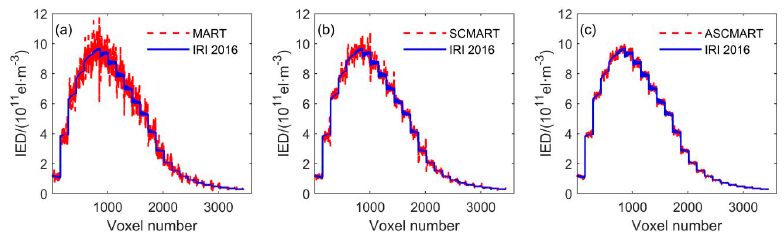
Figure 3. Comparison between the simulated ionospheric electron density distribution of the IRI 2016 model and the tomographic results of the three algorithms. ( a ) MART ( b ) SCMART ( c ) ASCMART. Table 1 provides the reconstructed error statistics of the three algorithms based on all voxels.